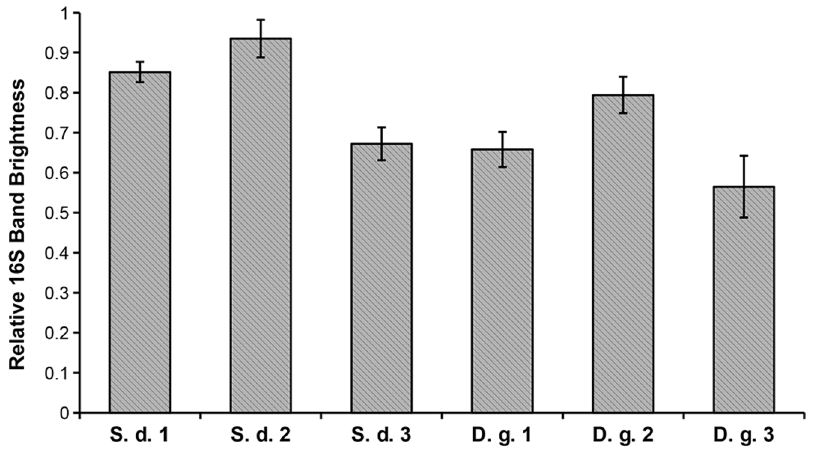
Figure 5. Statistical Verification of Repeatability of Assay Measurements. Shown are mean relative brightness measurements of the 16S band (bars showing 6 standard error) from triplicate assays performed on six monospecific choanoflagellate cultures; three S. diplocostata (S.d. 1–3) and three D. grandis (D.g.1–3). The values are significantly different (F 5,57 =10.48, P , 0.001) between the cultures such that measurements are repeatable and representative of the culture they are taken from.